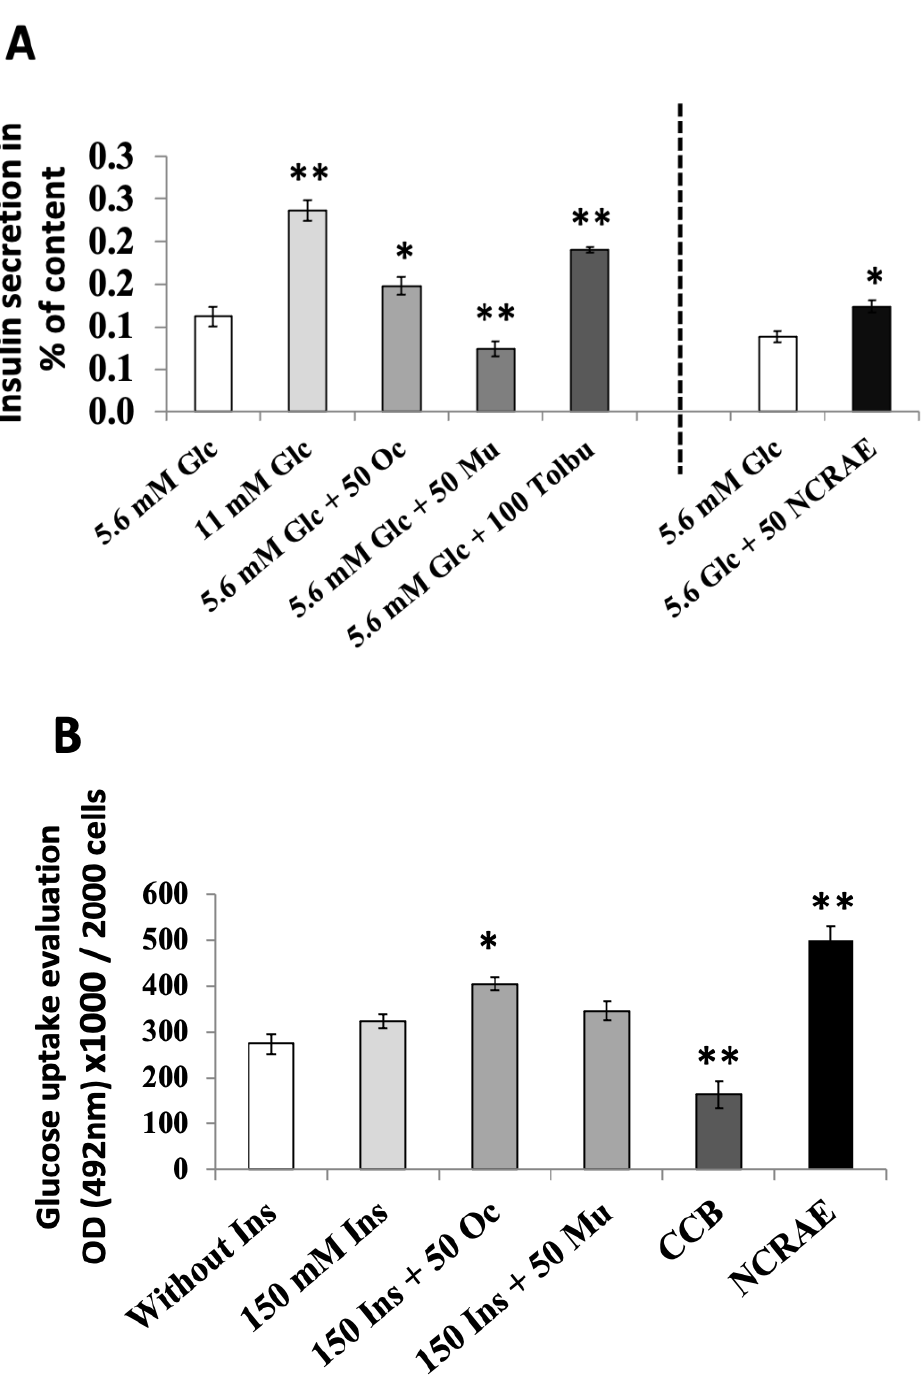
Figure 3. Insulin release and glucose uptake effects of Oc extract or Mu extract. ( A ) Insulin release of INS1 β cells in the presence of 5.6 mM glucose, with or without 50 µ g · mL − 1 of extracts (Oc and Mu). Comparison with NCRAE (reference extract) and tolbutamide as control. Values are the means ( ± SD) of three independent experiments (* p < 0.05 and ** p < 0.01). ( B ) Glucose uptake evaluation of muscles cells in the presence of 150 nM insulin, with or without 50 µ g · mL − 1 of extracts.